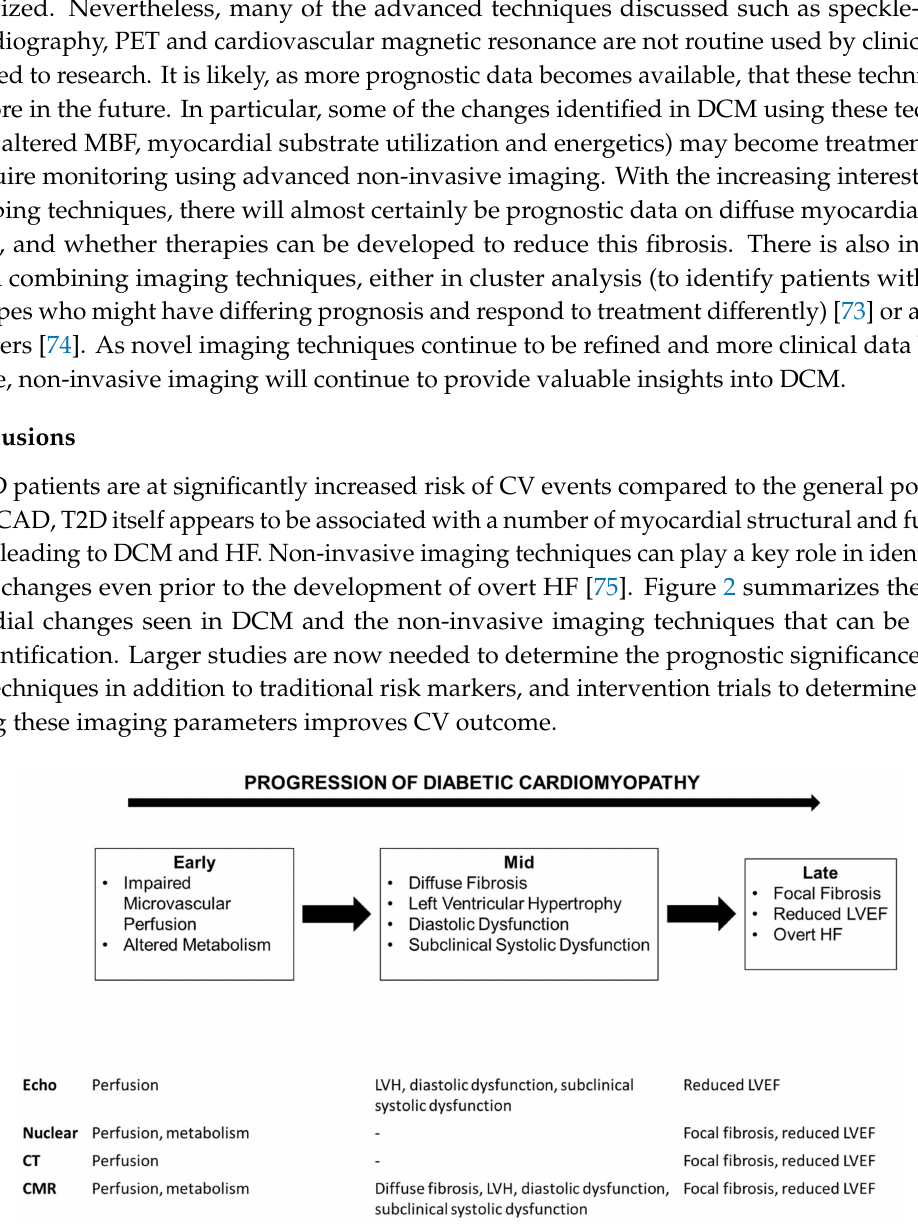
Figure 2. Overview of the structural and functional abnormalities occurring in the progression of diabetic cardiomyopathy and the non-invasive imaging techniques that can be used to assess